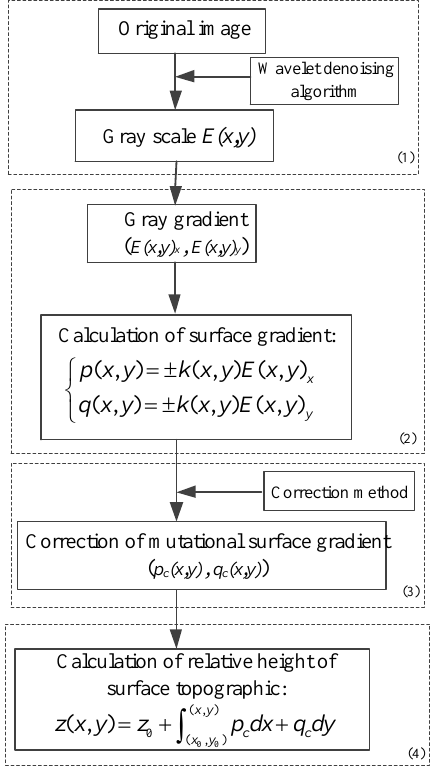
Figure 8. Analytic reconstruction algorithm.